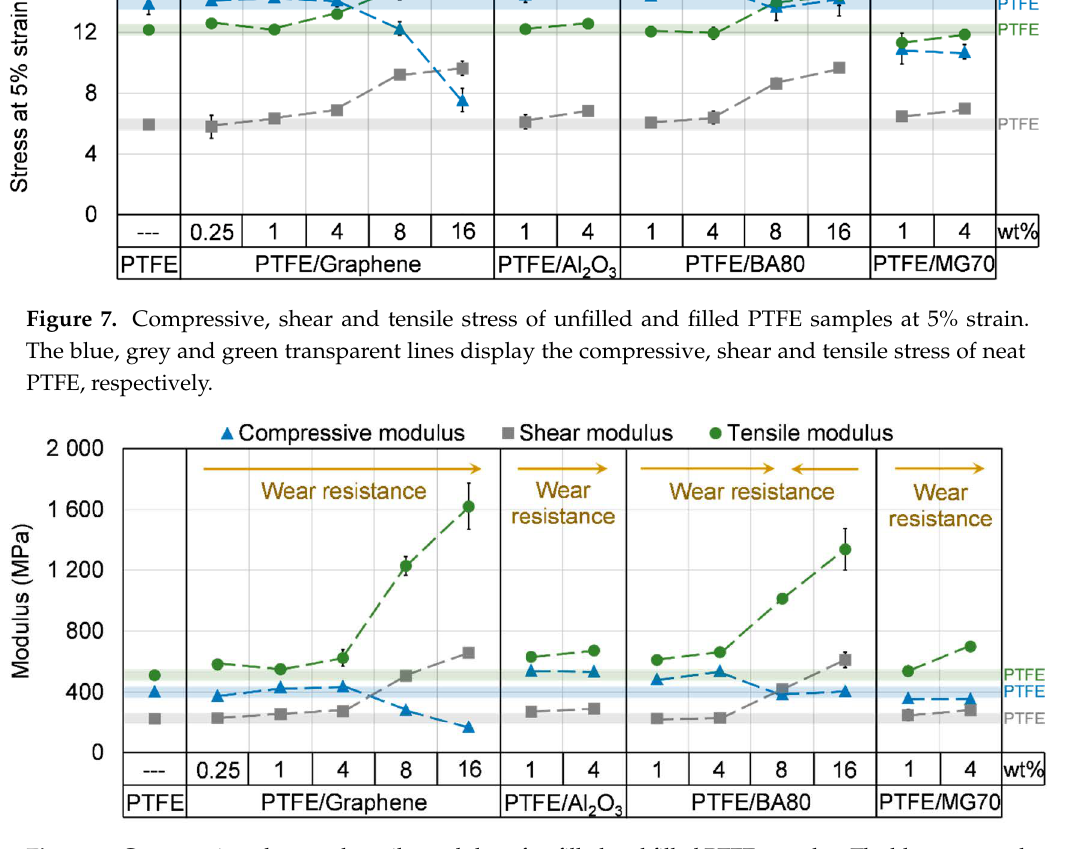
Figure 8. Compressive, shear and tensile modulus of unfilled and filled PTFE samples. The blue, grey and green transparent lines display the compressive, shear and tensile modulus of neat PTFE, respectively. Table 5. Average compressive stress at 5% and 10% strain and average compressive modulus of the sintered materials at 50 ◦